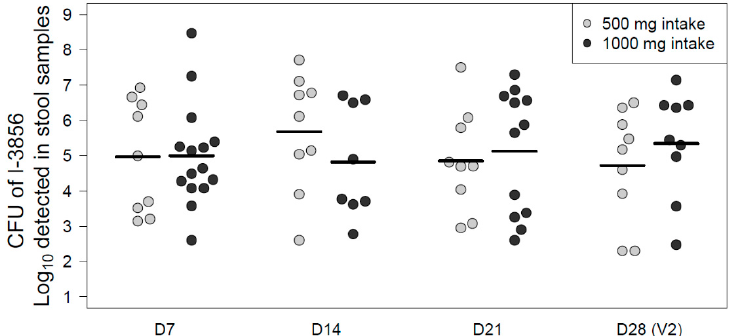
Figure 4. Proportion of women (%) with S. cerevisiae CNCM I-3856 detected in stool samples at each study timepoints ( n = 19 for Probiotic 500 mg group, n = 19 for 1000 mg group and n = 19 for placebo group).